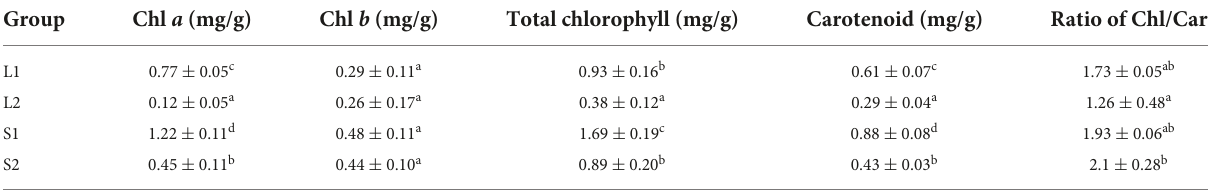
TABLE 1 The photosynthetic pigment content in green-leaf and yellow-leaf plants under different light